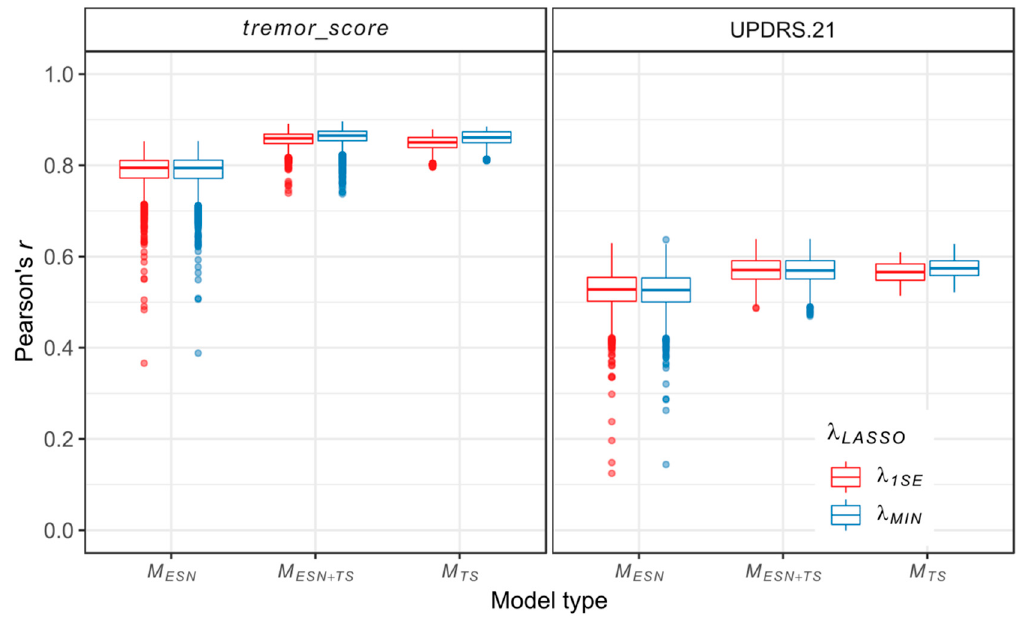
Figure 4. Distribution of correlations (measured with Pearson’s r ) between individual model predictions and target values. Results are grouped according to the model type and the λ LASSO regularization parameter.